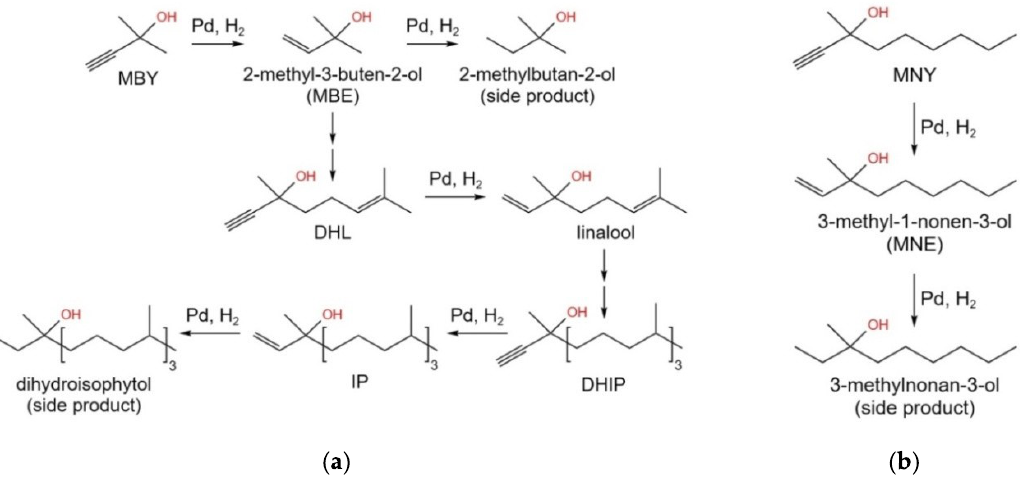
Figure 1. Simplified scheme of MBY transformation to isophytol (IP)—so-called “acetylenic process” ( a ) and scheme of MNY hydrogenation ( b